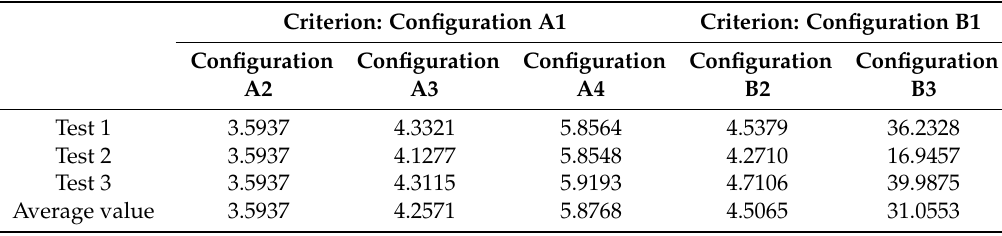
Table 13. The standard deviation of electric motor torque under different configurations (unit: